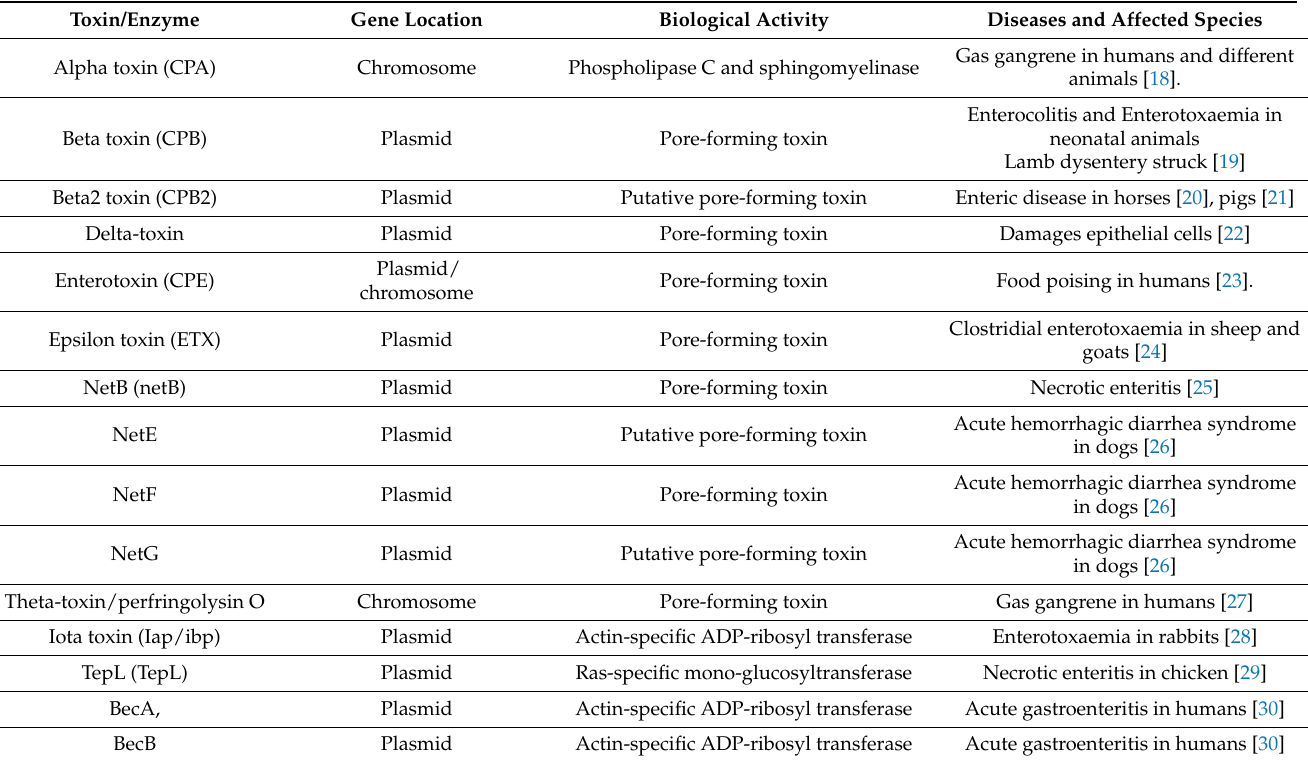
Table 2. Toxins secreted by various strains of C. perfringens , their genetic location and mode of